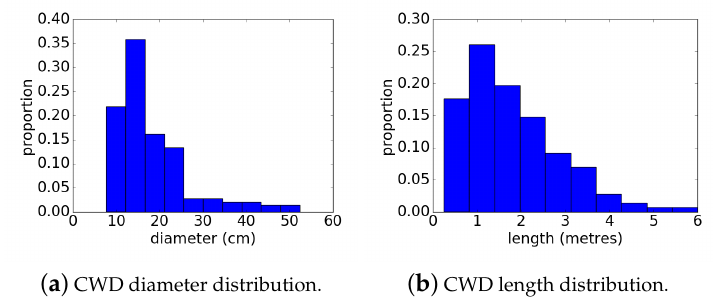
( a ) CWD diameter distribution. ( b ) CWD length distribution. Figure 11. Size distribution of CWD in terms of ( a ) diameter and ( b )